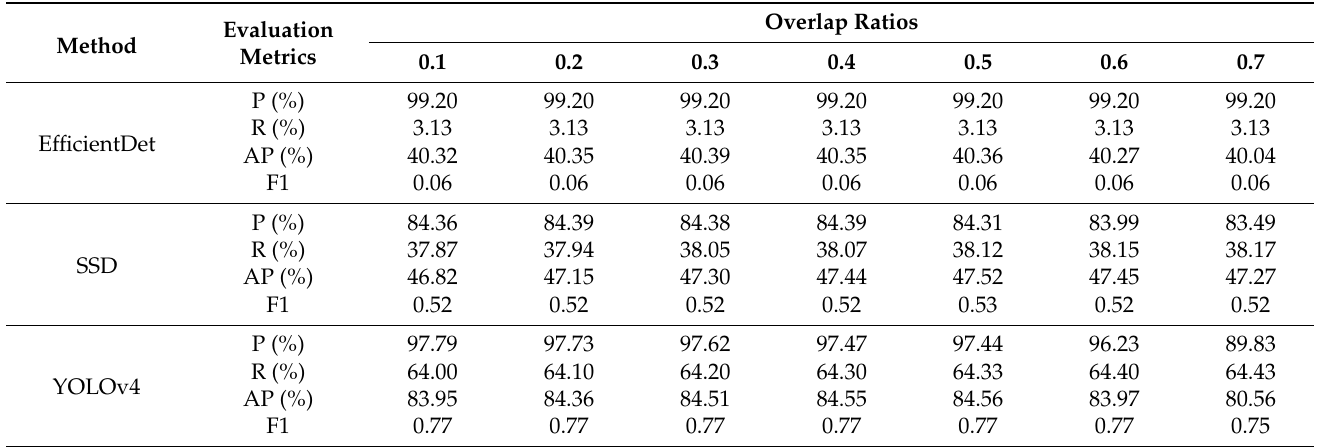
Figure 10. Statistical results of positive and negative sample numbers for each method with different overlap ratios (the histogram in the figure corresponds to the number of positive samples, the line graph corresponds to the number of negative samples; blue, green, and orange correspond to the three methods of EfficientDet, SSD, and YOLOv4, respectively). Table 3. Performance evaluation results of each method with different overlap